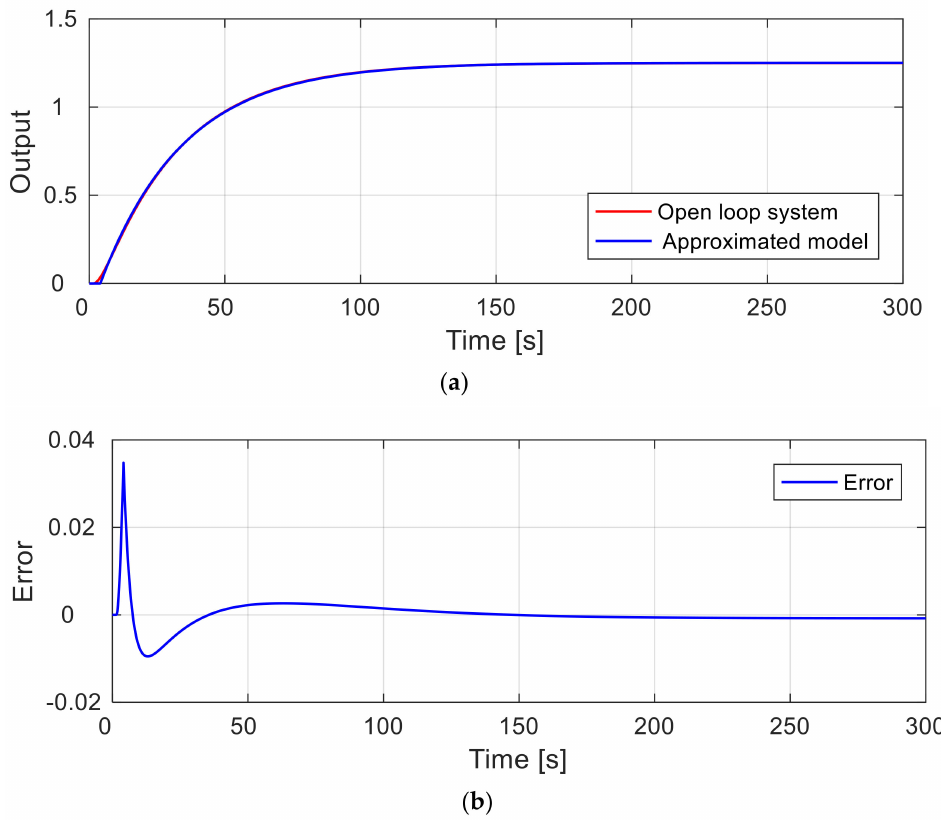
Figure 5. Validation of the approximated FOPTD model. ( a ) Outputs; ( b )